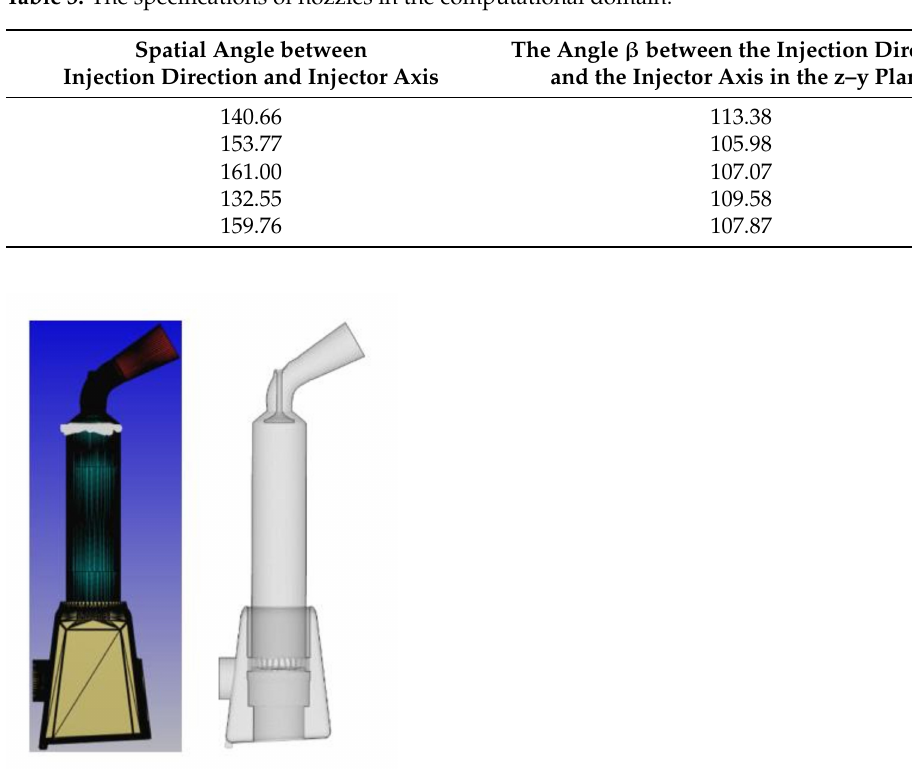
Figure 2. Schematic diagram of the z–y plane of the injectors and the injection direction. Table 3. The specifications of nozzles in the computational domain.